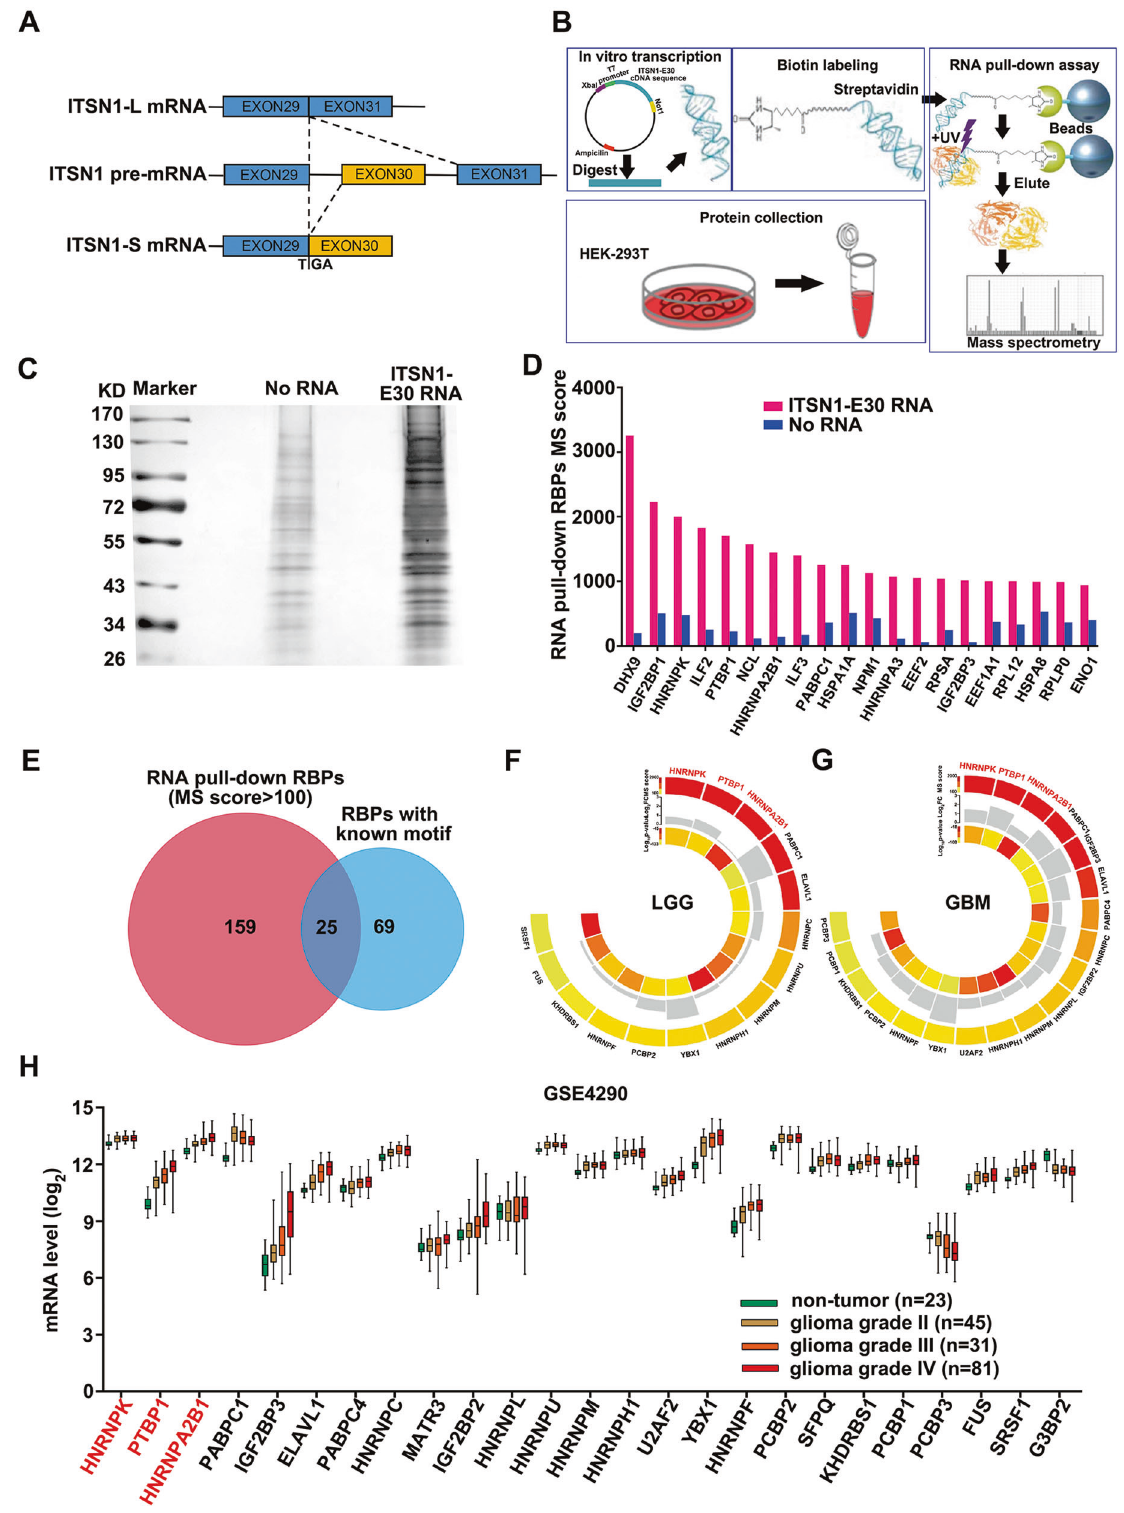
Fig. 2 Three candidate RBPs were capable of binding exon 30 and adjacent intronic areas of ITSN1 RNA. A Schematic representation of the two isoforms of human ITSN1 resulting from an alternative splicing. B Schematic diagram of RNA pull-down assay and proteomics approaches. C In vitro RNA pull-down assay. Proteins were subjected to SDS-PAGE and silver stained after pull-down. D The top 20 RBPs ranked by MS score of RNA group. E The Venn diagram showed 25 overlapped RBPs between 184 RNA pull-downed RBPs (MS score >100) and 94 RBPs with known binding motifs. F , G Circos plots showed the differential expression analysis of the 25 overlapped RBPs in LGG ( F ) or GBM samples ( G ) and their paired normal samples from GEPIA (cut-off: |log 2 FC| > 1, q -value < 0.01). H A box plot showed the expression pro fi le of the overlapped RBPs across non-neoplastic samples and grade II-IV glioma